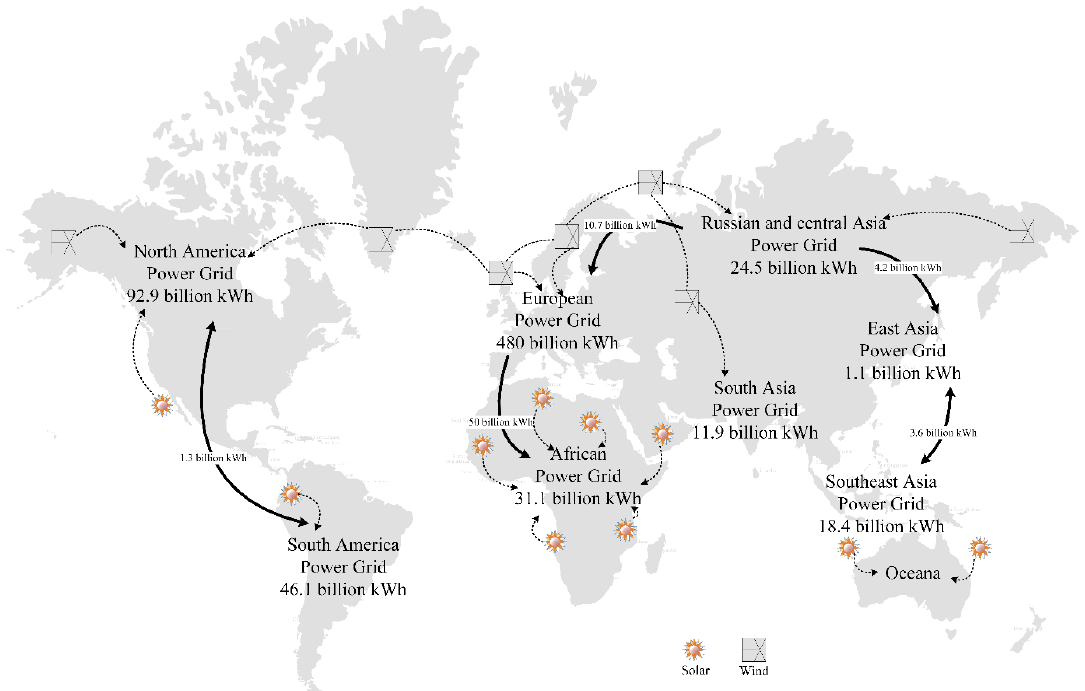
Figure 17. The state and future of interconnected power-sharing grids around the globe